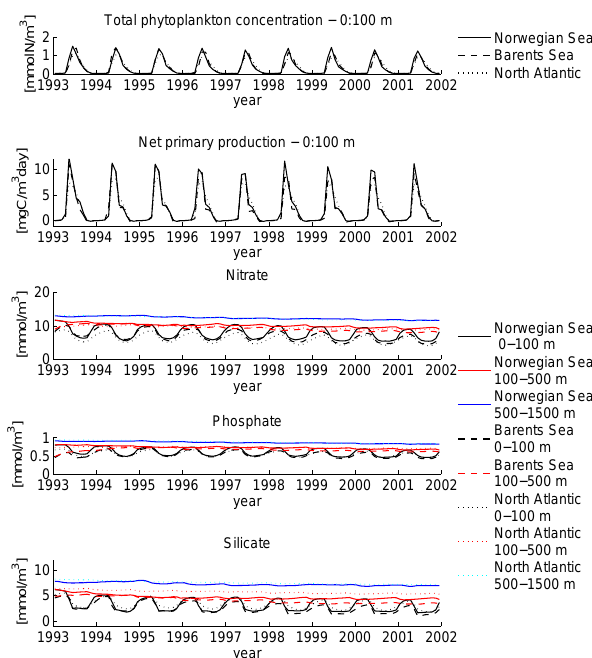
Figure 3. The temporal evolution of total phytoplankton, net pri- mary production, and of the three nutrients in different depth inter- vals from initialization in 1993 to the end of 2001. Norwegian Sea and Barents Sea are here the boxes shown in Fig. 1. North Atlantic here refers to the area 80 ◦ W–80 ◦ E, 60–80 ◦